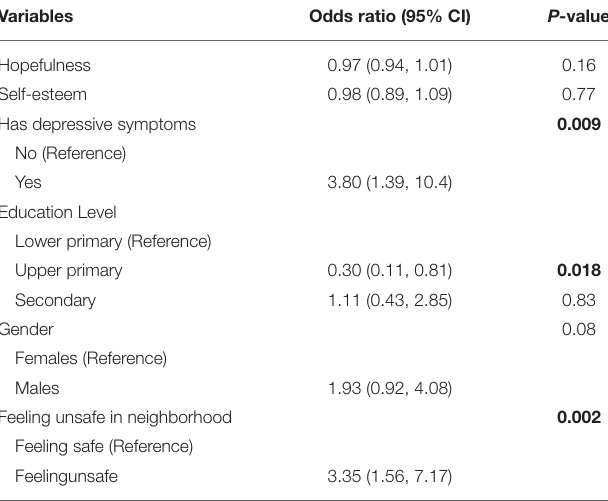
TABLE 2 | Breakdown of the forms of experienced sexual risk behaviors (SRB) among the study participants reporting SRB ( N = 39). Forms of SRB